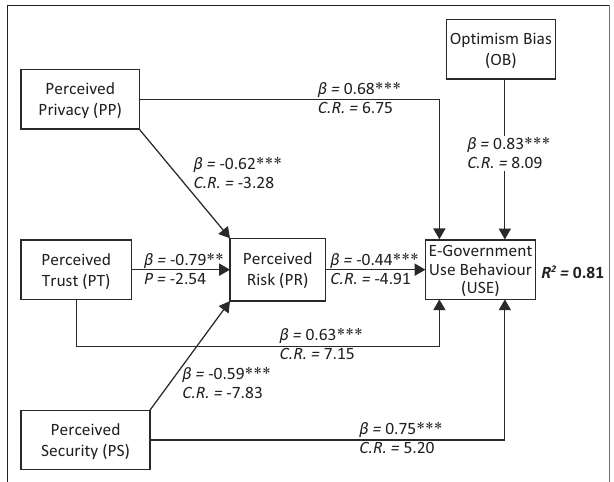
FIGURE 2: Structural model path coefficients.